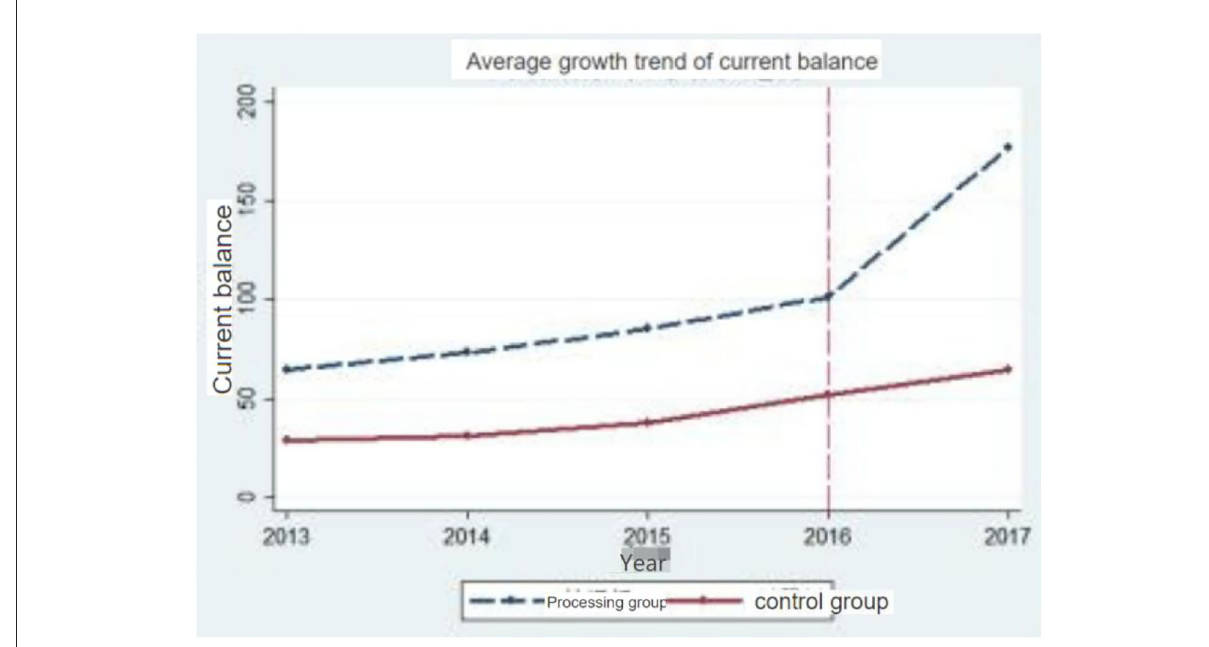
FIGURE1 Parallel trends of current balances of medical insurance